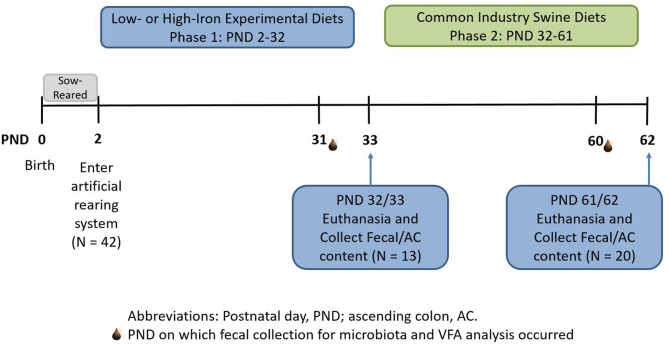
Experimental timeline. Piglets were born on postnatal day (PND) 0 and sow-reared for the first 2 days of life. On PND 2, 42 intact male piglets were brought into the artificial rearing system and placed on either an iron deficient (ID) or control (CONT) milk replacer until PND 32. Nine pigs were removed from the study due to failure to thrive or complications during neuroimaging procedures. At PND 32 (N = 13; CONT, n = 6; ID, n = 7), 13 pigs were euthanized to allow tissue collection. Twenty pigs from phase 1 continued on to common industry swine diets during phase 2. At PND 61 or 62 (N = 20; n = 10 per phase 1 diet), remaining pigs were euthanized to allow tissue collection at the end of the study. CONT, control diet; ID, iron deficient diet; PND, postnatal day.